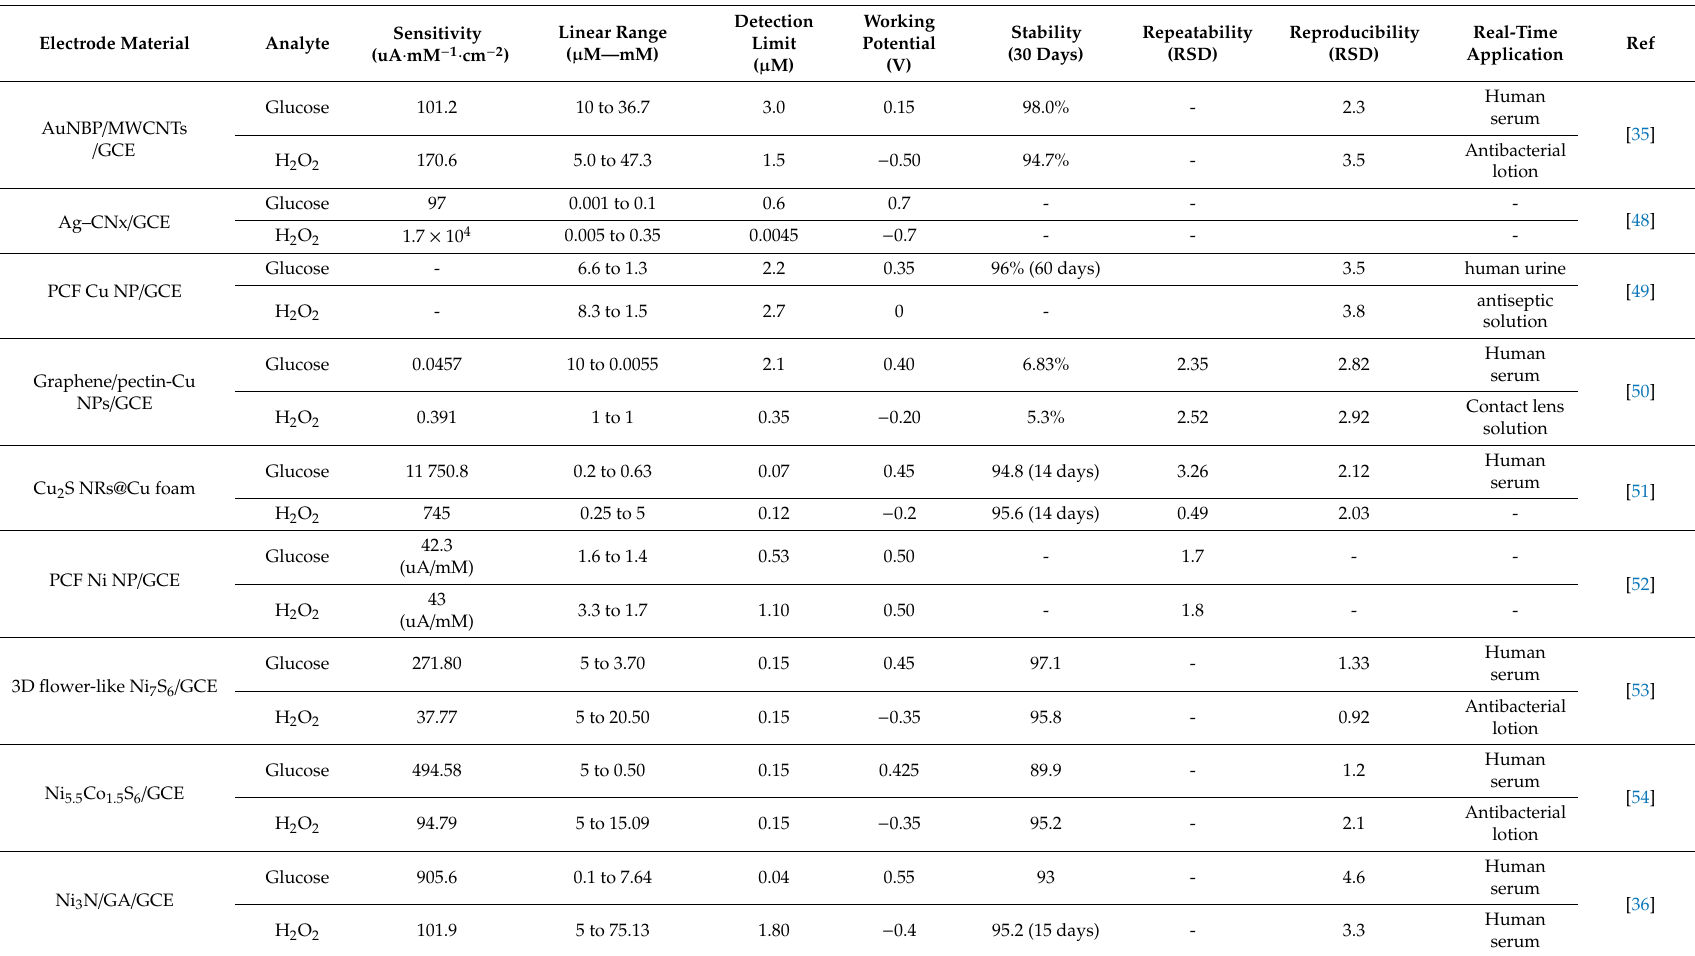
Table 1. Performances of non-enzymatic glucose and H 2 O 2 electrochemical sensors based on metal